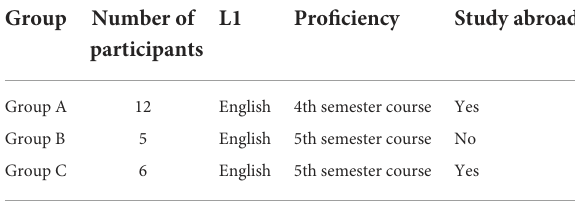
TABLE 1 Participants in the